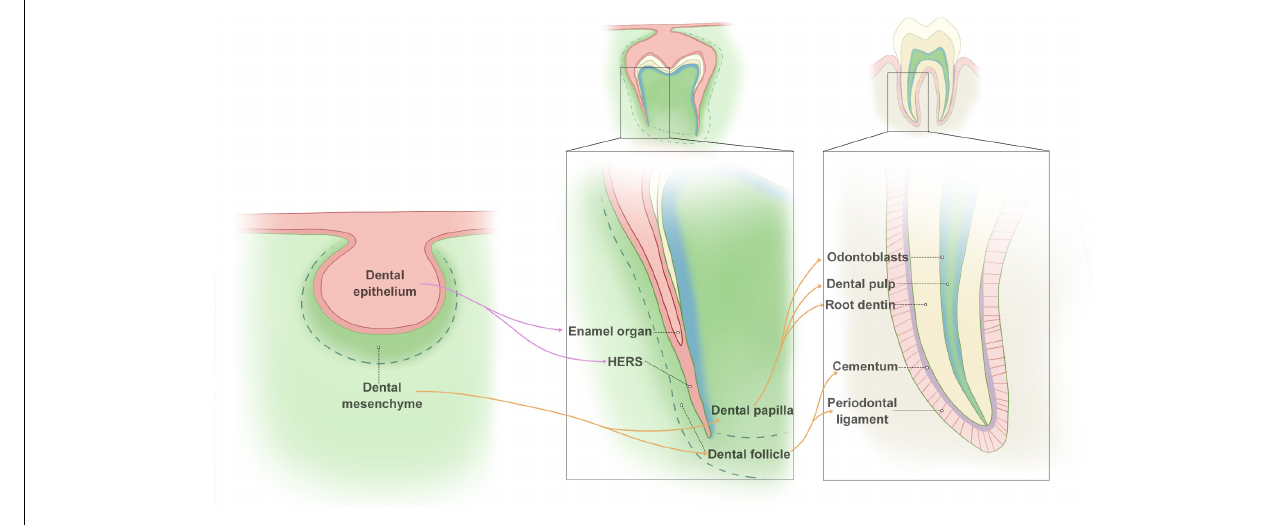
FIGURE 1 | Summary of root